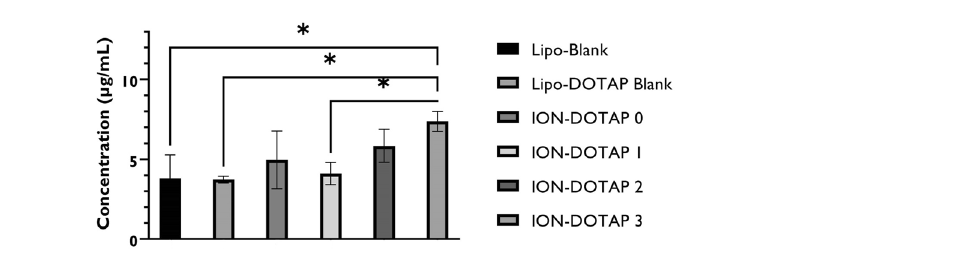
Figure 8. Coumarin-6 levels in HeLa cells post-incubation with β-ionone liposomes containing Coumarin-6 prepared with various concentrations of DOTAP for two hours.